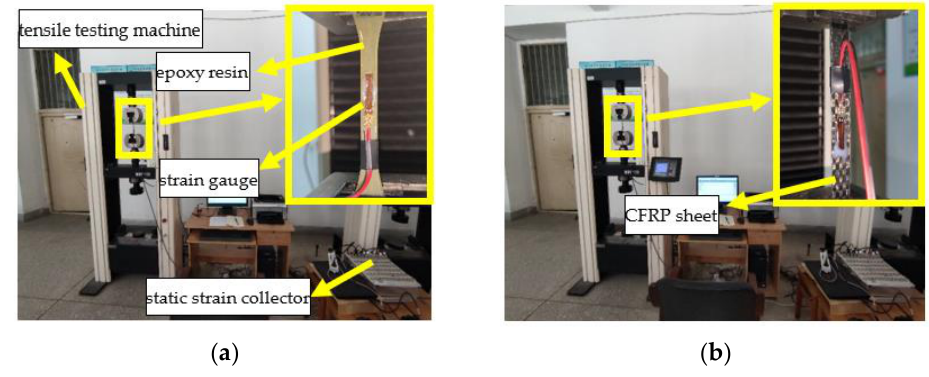
Figure 10. Tensile mechanical test: ( a ) epoxy resin and ( b ) CFRP sheet.